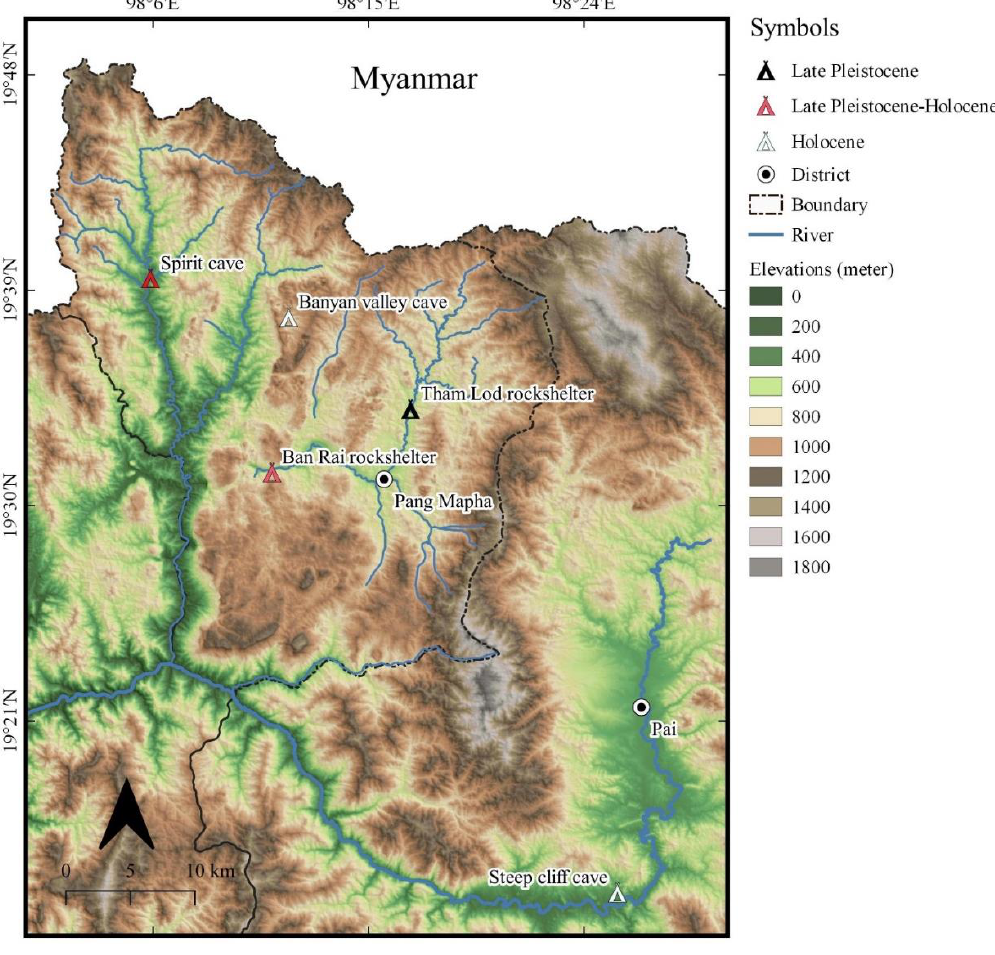
Figure 1. The location of archaeological sites within northwest Thailand discussed in the text, including Ban Rai Rockshelter in Pang Mapha District, Mae Hong Son Province.